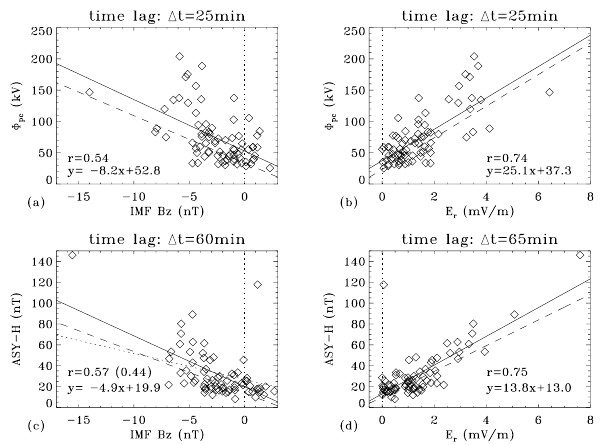
Fig. 4. Cross-polar potential drop versus (a) IMF B z , and (b) E r at the time lag of peak correlation. ASY-H versus (c) IMF B z and (d) E r , also for optimum time lag. Best linear fit for Astrid-2 and ACE spacecraft (solid line), and for FAST and Wind spacecraft (dashed